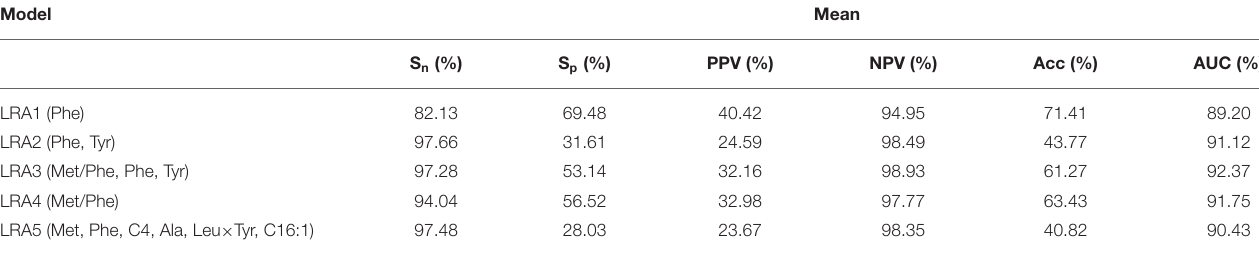
TABLE 7 | Classification performance of the LRA2–LRA4 classifiers.